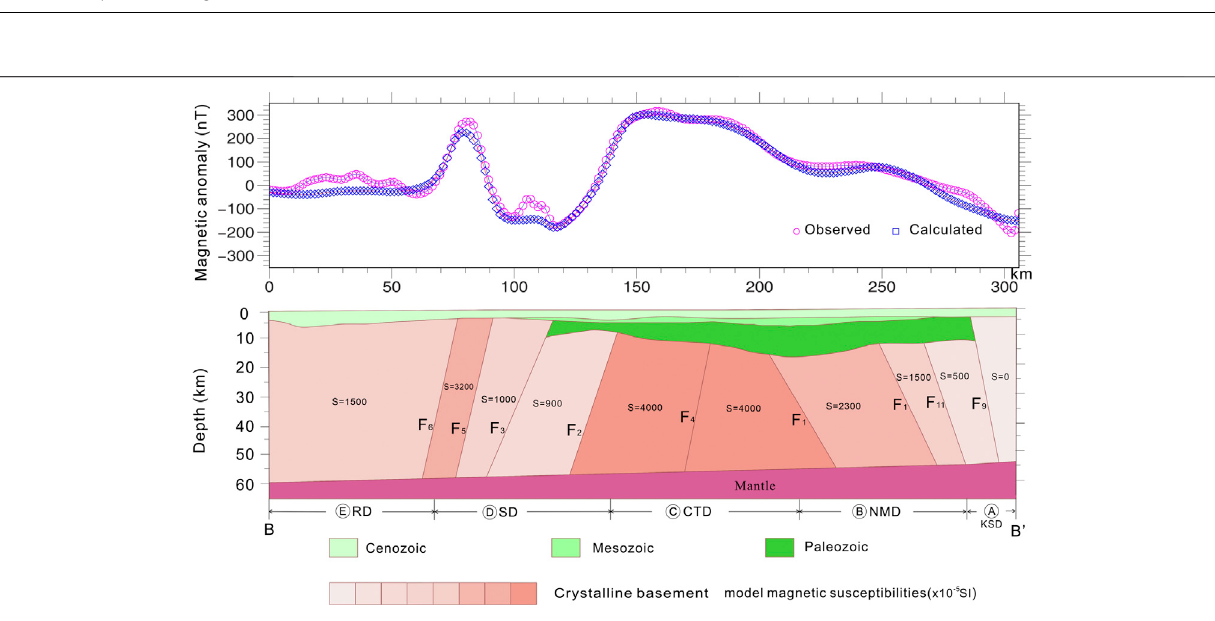
Frontiers in Earth Science |